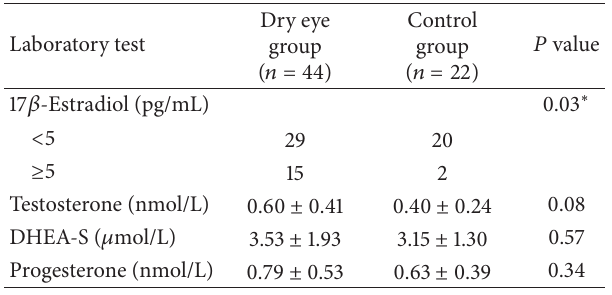
Table 2: Comparison of serum levels of sex steroids between the dry eye group and the normal control group.